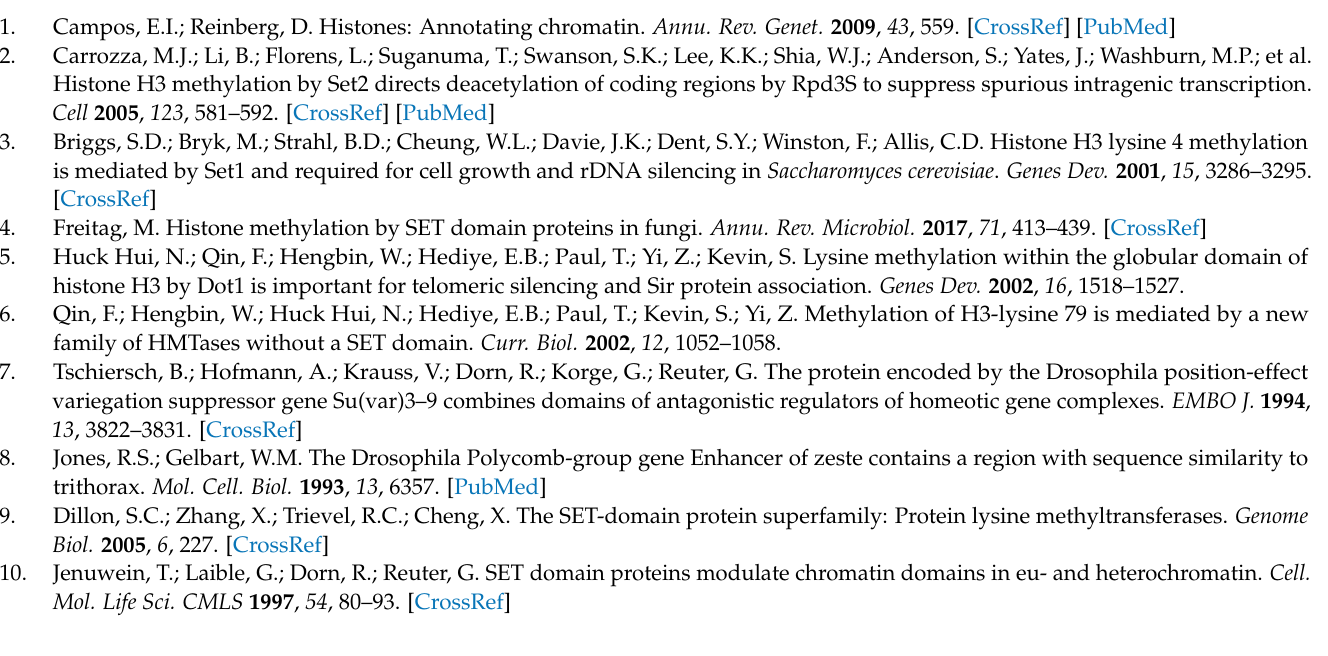
Figure S3. Various expansions and contractions among the fungal lineages using CAFE analysis. The numbers present on each node correspond to the expansion and contraction numbers of orthologues genes predicted by CAFE. Table S1. Distribution of SET-domain genes in 229 fungal organisms. Numbers in brackets represent the deleted gene numbers which show ambiguously aligned regions around the three active catalytic